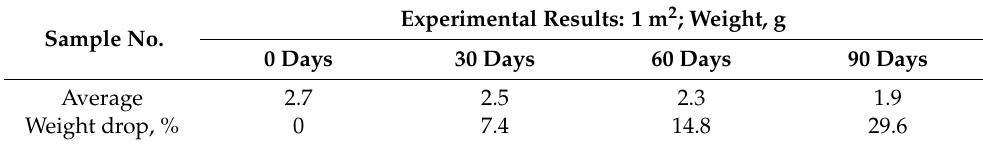
Table 1. Experimental results: 1 m 2 ; weight, g. Sample